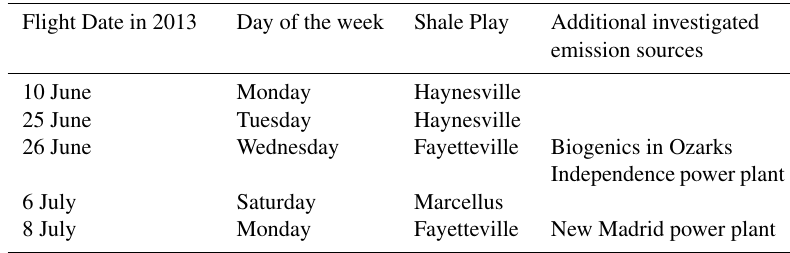
Table 4. Flight descriptions for the NOAA WP-3D flights in shale gas regions.